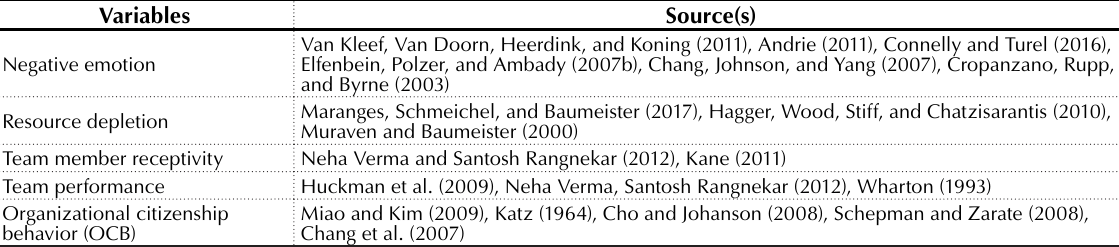
Source: Secondary data.